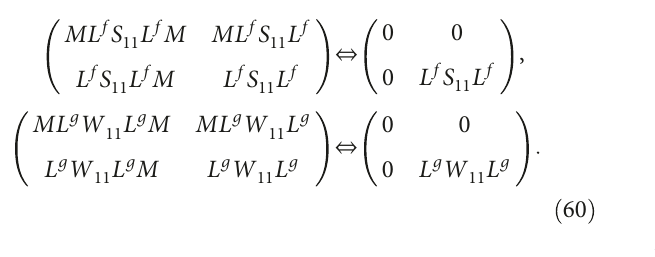
Figure 2: The intermittent control time sequence in Example